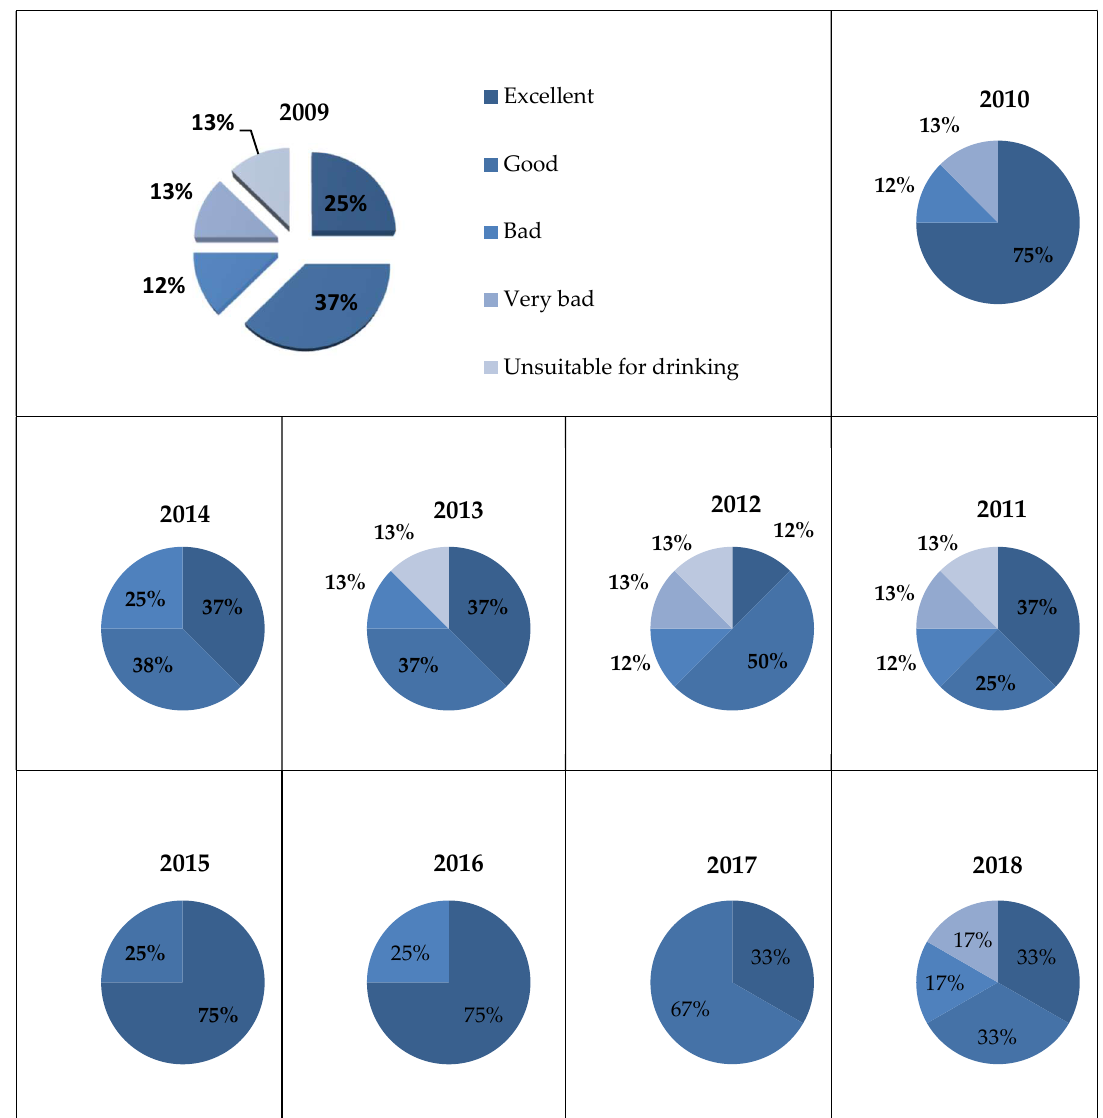
Figure 6. Percentage of groundwater quality at eight wells based on GWQI in the dry season during 2009–2018.